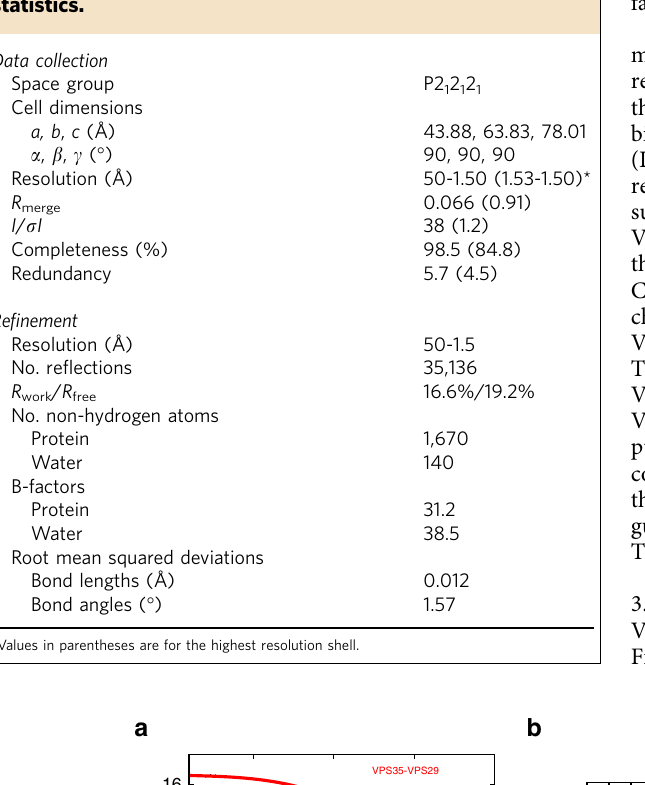
Table 1 | Crystallography data collection and refinement statistics.